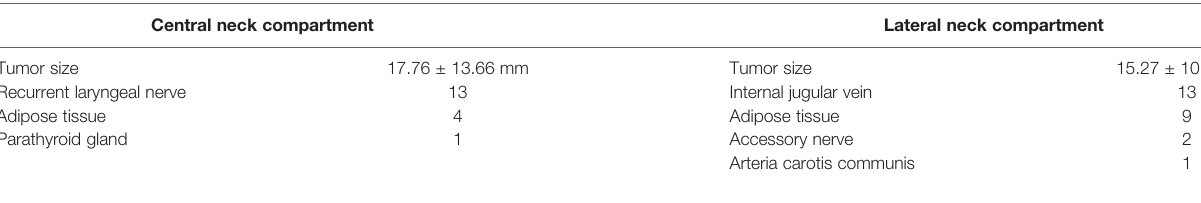
TABLE 2 | Extranodal extension in the central and lateral neck